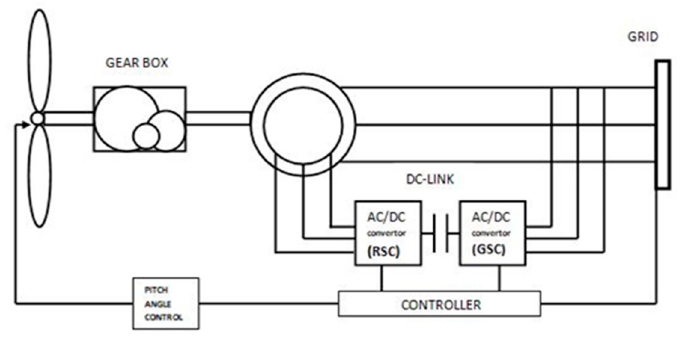
Figure 1. DFIG-based wind turbine model.